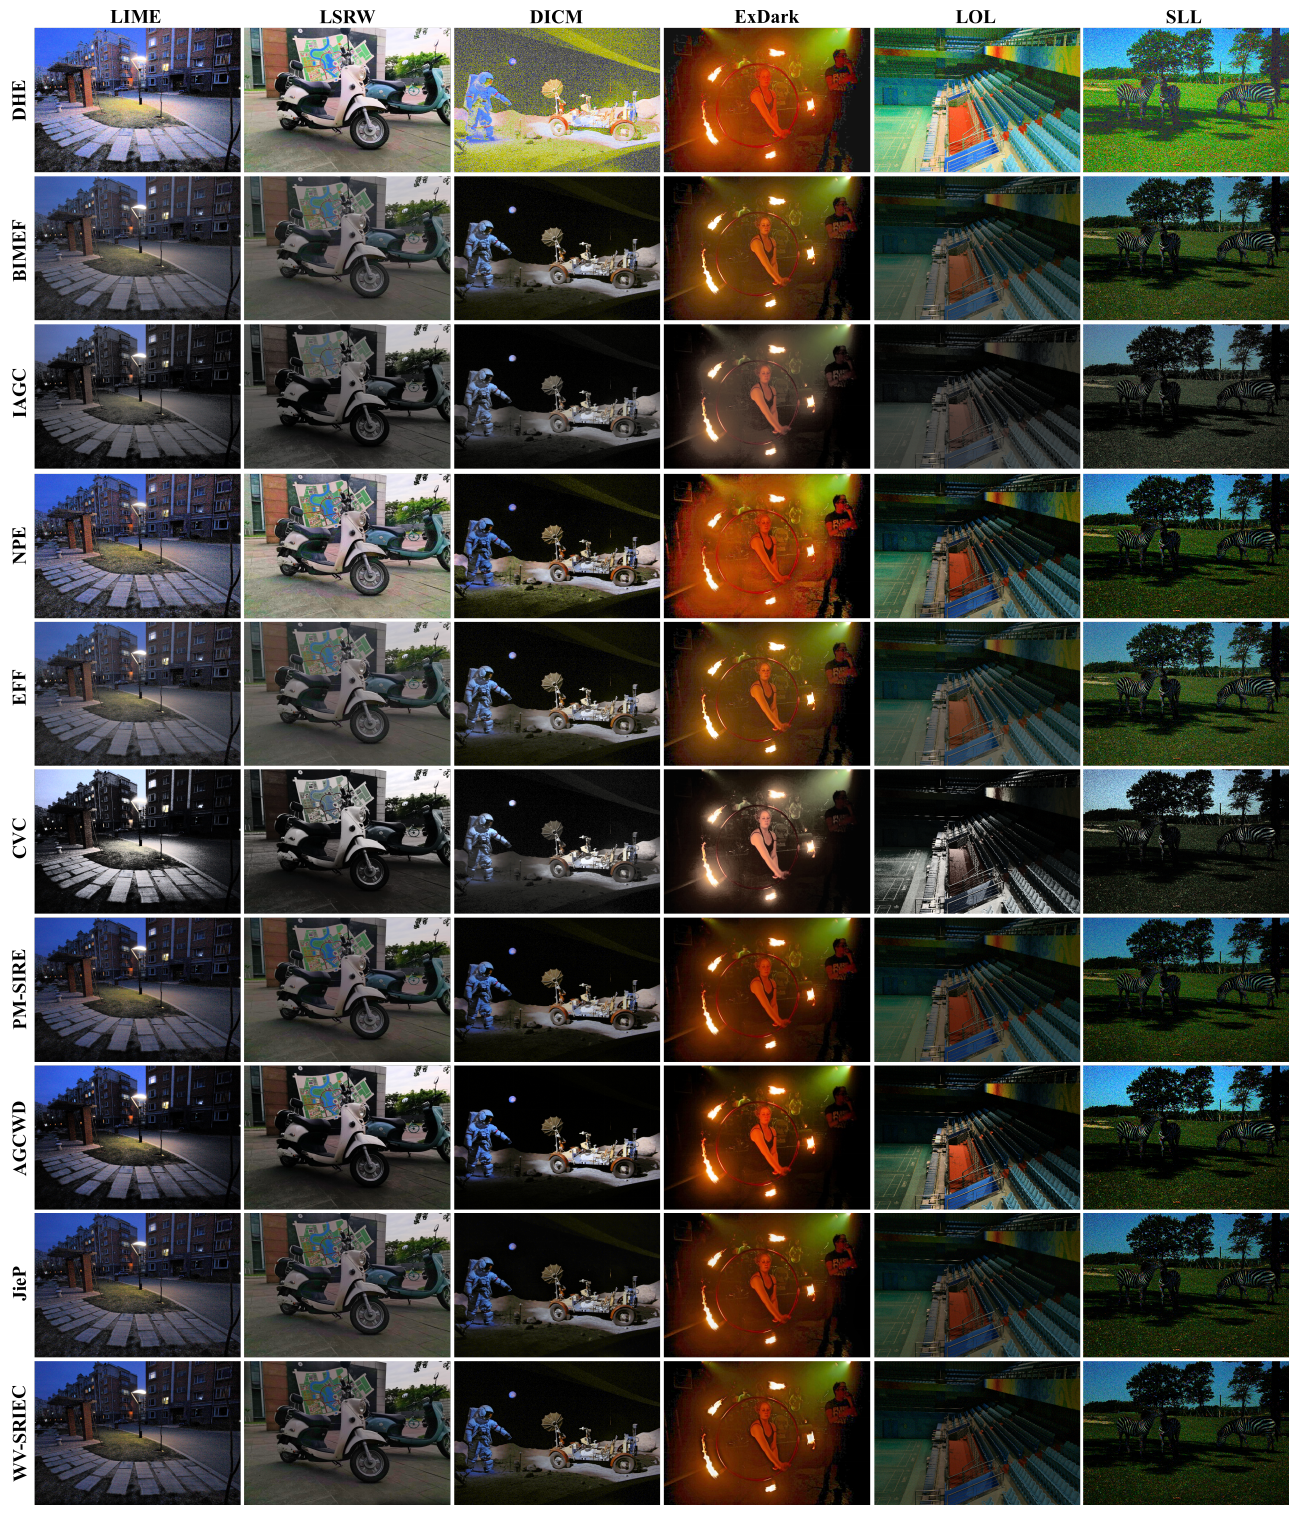
Figure 2. A visual representation of results from top ten classical methods on six datasets. The rows are showing the results produced by different algorithms, whereas the columns are showing